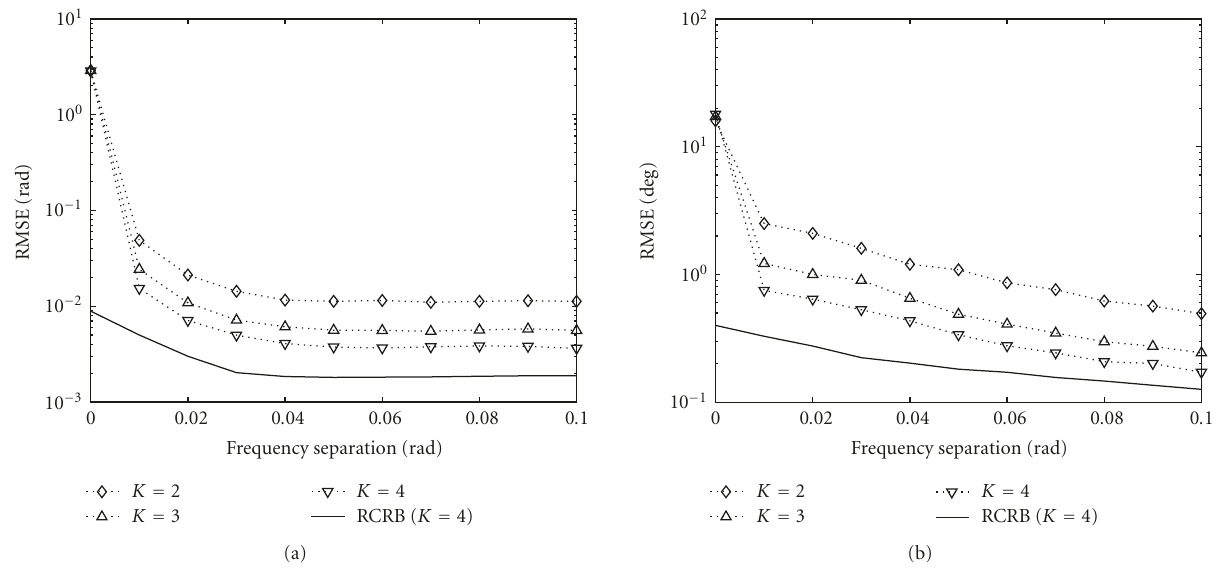
Figure 7: RMSE curves of the proposed method for frequency and DOA estimation of the first signal versus frequency separation with fixed SNRs = 15 dB, M = 8, and N = 100. (a) Frequency estimation. (b) DOA